Question: In one sentence, what is this figure communicating?
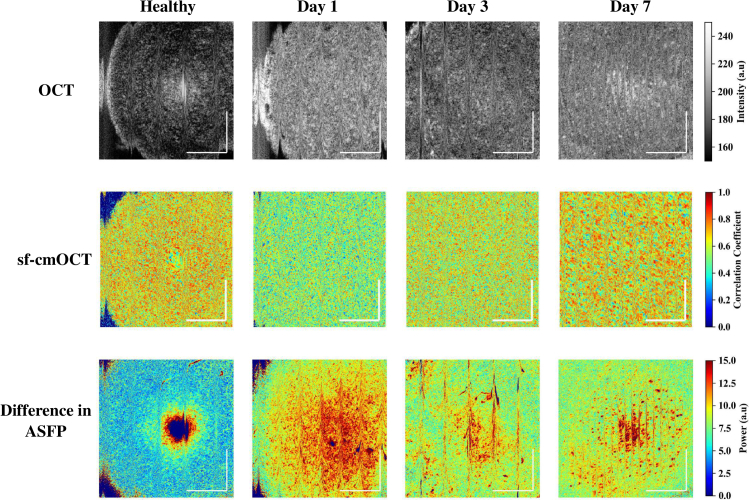
Answer: En face images of MSC-EV corneal treatment progression using conventional OCT, sf-cmOCT, and difference in ASFP method for healthy, day 1, day 3, and day 7. Scale bar – 300 µm.